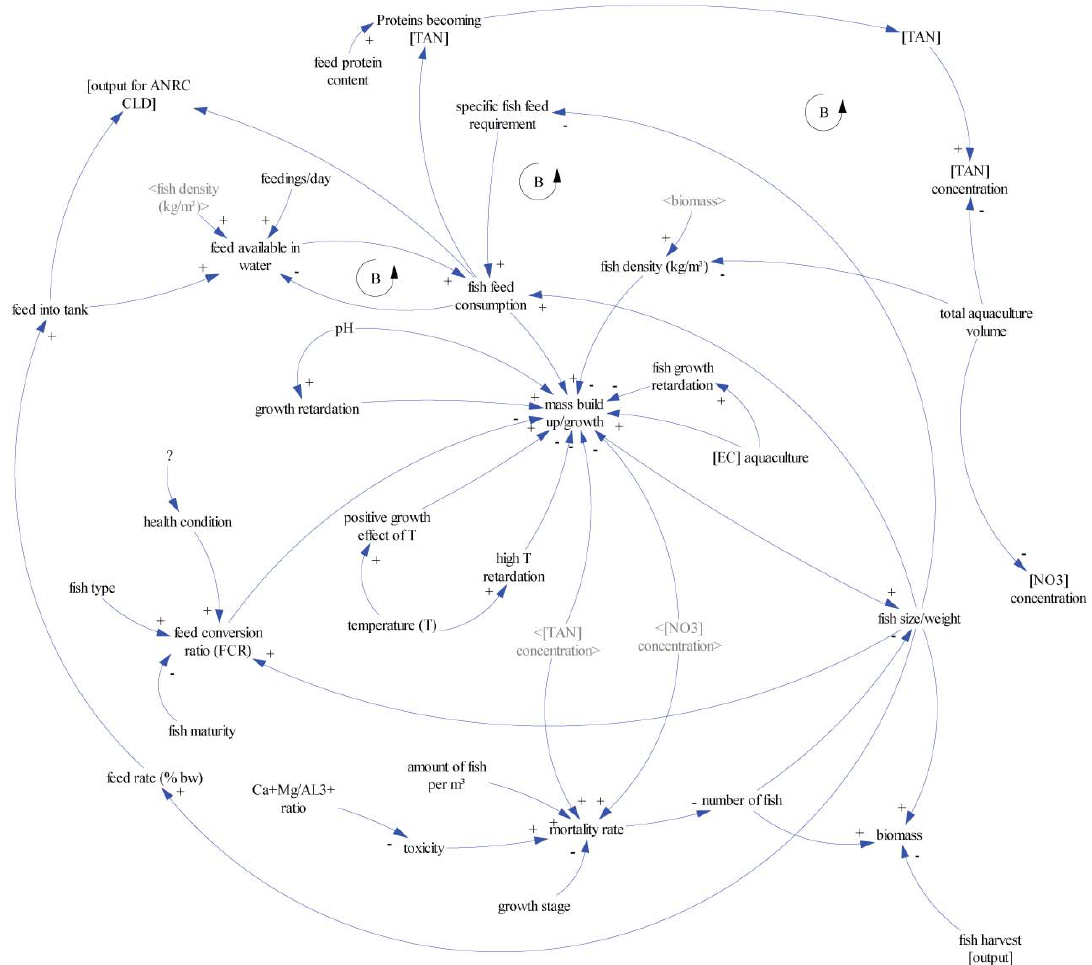
Figure B1. Causal loop diagram of the RAS. Together with the flow charts in Figures 5 and 7–9, this CLD was used to create the RAS AnyLogic model shown in the Appendix Figures A1 and A2. The CLD shows the impact of different water quality parameters on fish growth as well as the impact of the feed rate on the RAS-derived TAN and nitrate concentrations. The CLD comprises of several inputs of which the design inputs (e.g., amount of fish per m 2 ) that are fixed and the control inputs (such as pH, temperature, and feed input, etc.) are dynamic.